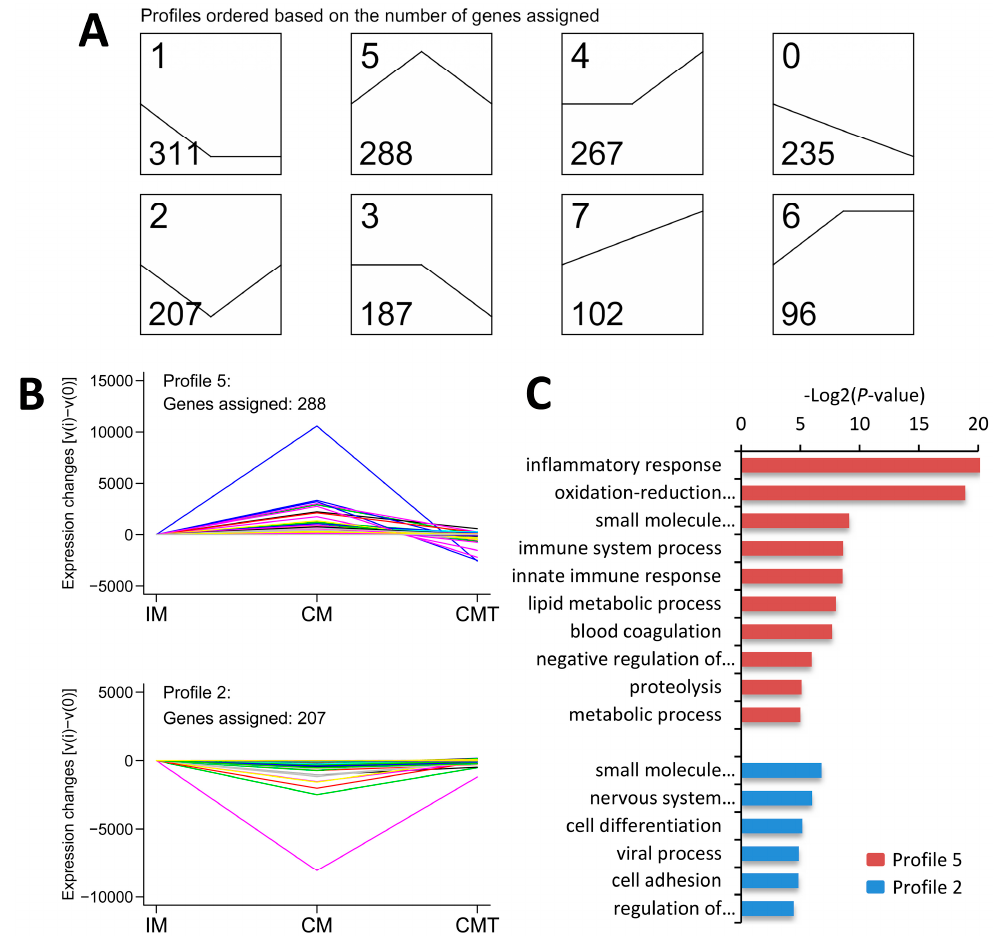
Figure 4. Gene expression tendencies and gene ontology (GO) analysis: ( A ) series-cluster analysis for gene expression profiles of DEGs; ( B ) gene expression tendencies of profile 5 and 2. Profile 5 included 288 DEGs that increased in CM pigs but decreased in CMT pigs compared with IM pigs, while profile 2 included 207 DEGs that decreased in CM pigs but increased in CMT pigs compared with IM pigs; and ( C ) Enriched GO terms in profiles 5 and 2. IM: intact male pigs fed a HFC diet; CM: castrated male pigs fed a HFC diet; CMT: castrated pigs with testosterone replacement fed a HFC diet.